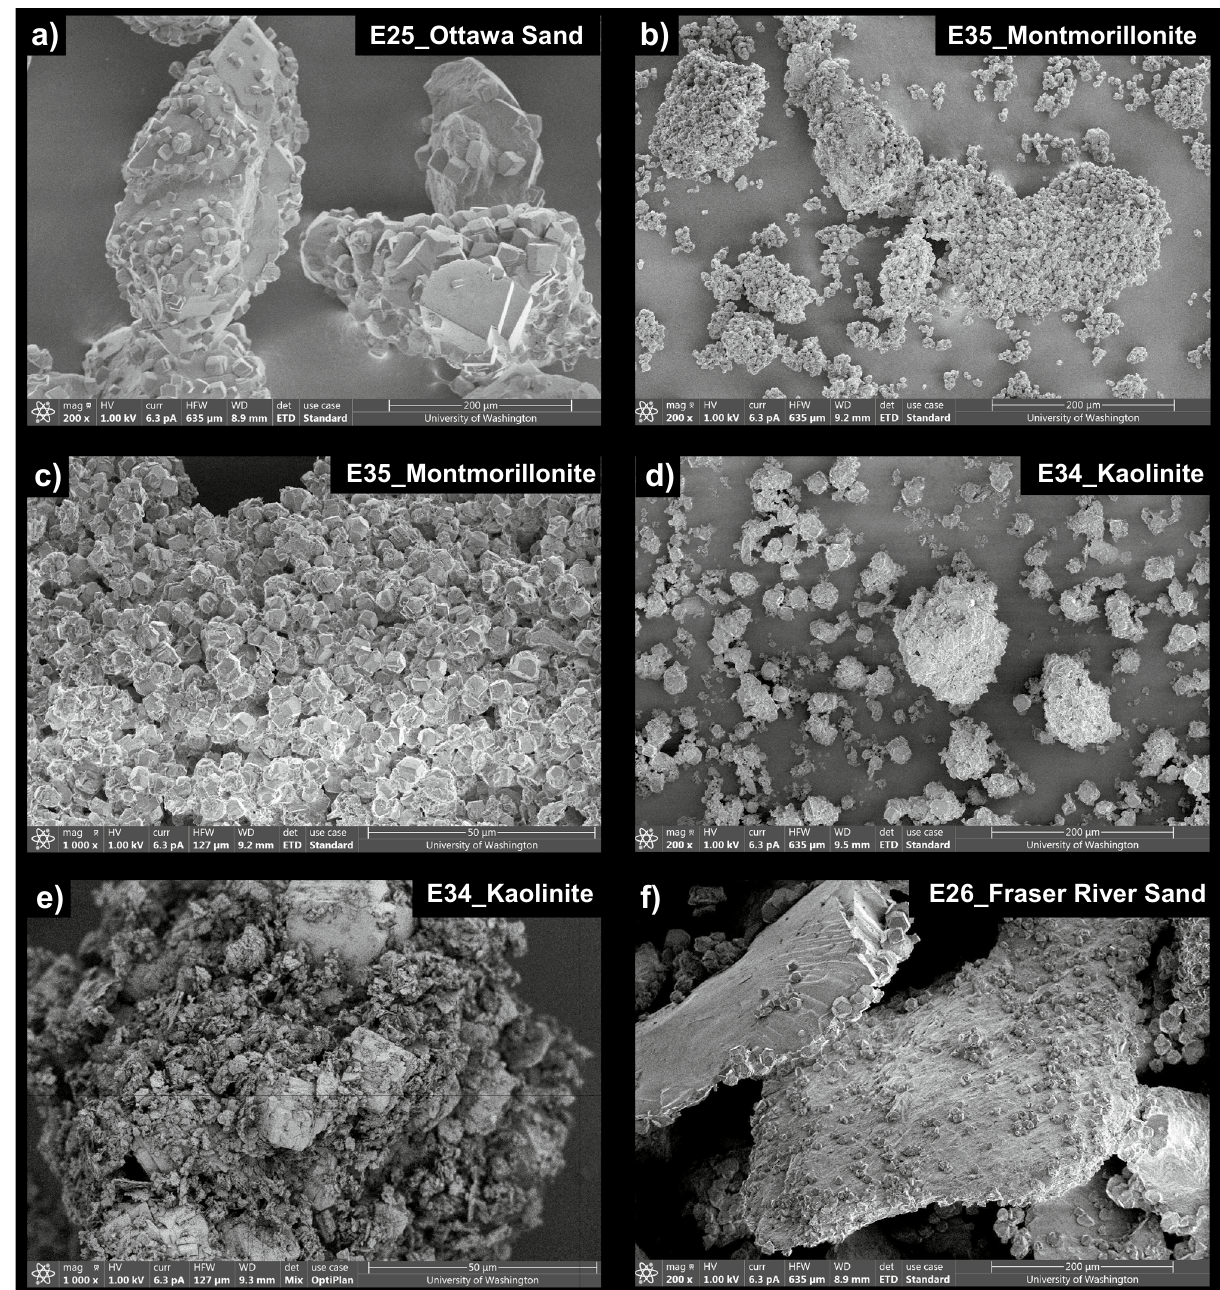
Figure 12. SEM images of precipitates from ( a ) Ottawa F-65 Sand, ( b, c ) montmorillonite, ( d, e ) kaolinite, and ( f ) Fraser River Sand